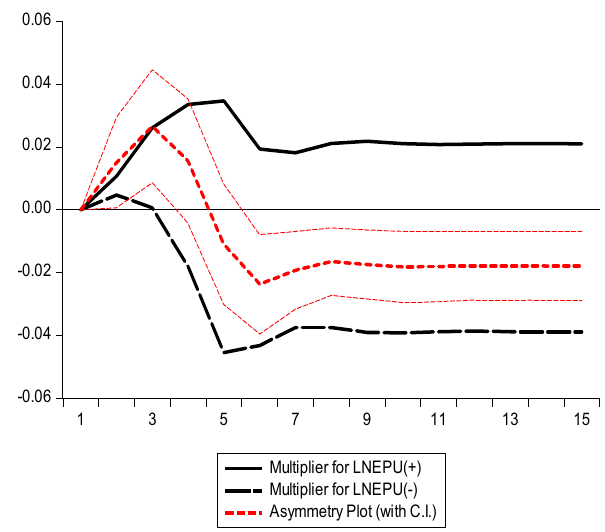
Figure 5. The dynamic multiplier for LNGTI.